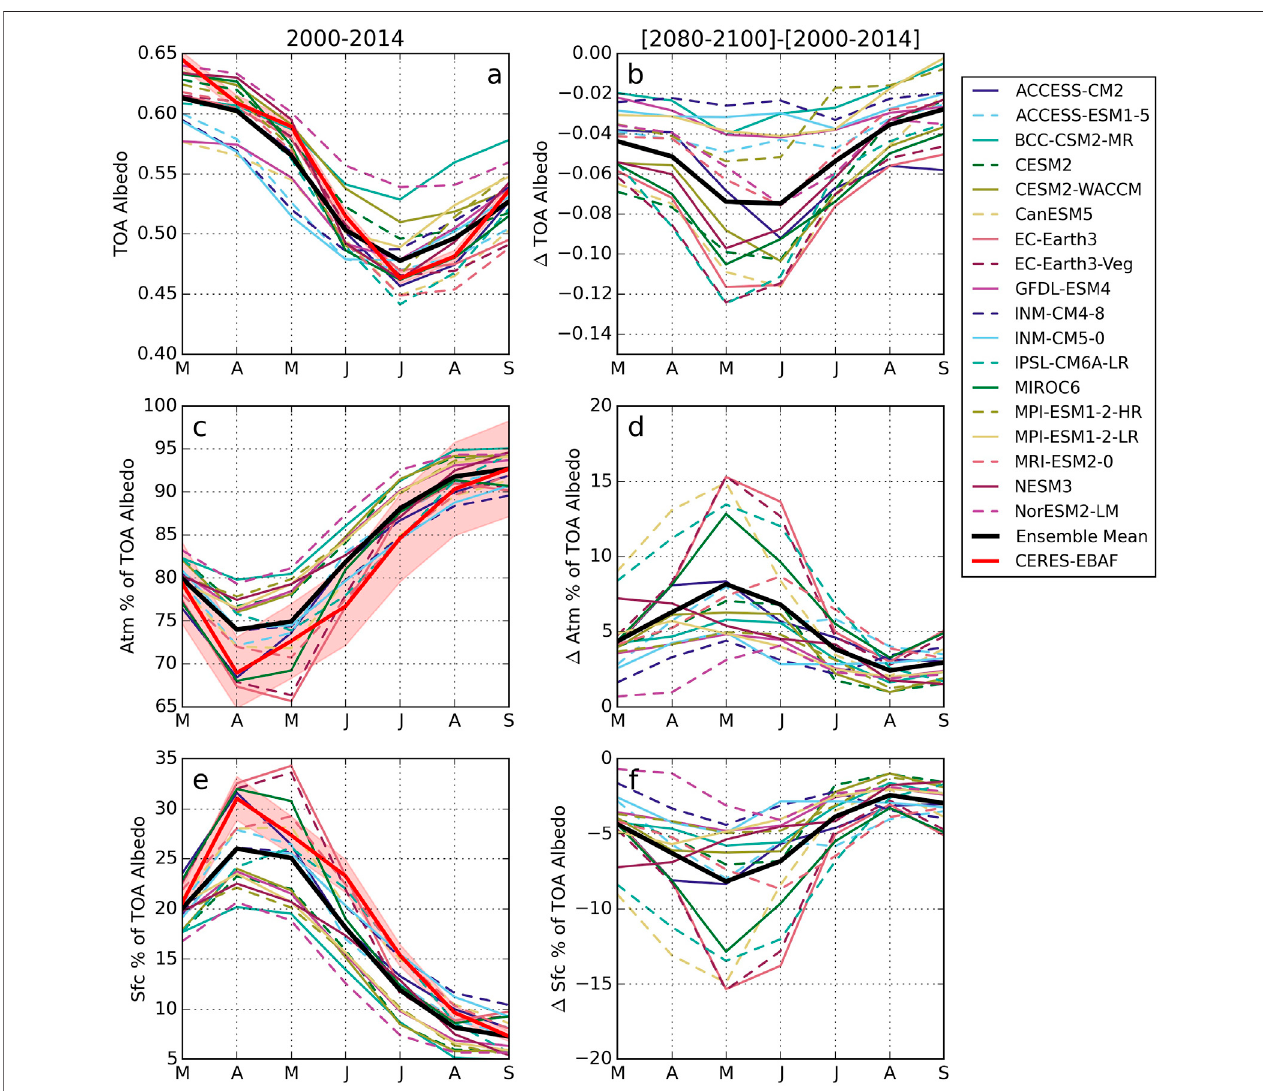
FIGURE 3 | Mean TOA albedo (A) and fraction of the TOA albedo contributed by the atmosphere (C) and surface (E) over 2000 – 2014 in CMIP6 and observations (CERES-EBAF),MarchthroughSeptember.Differencesbetweenhistoricalandendofcentury(2080 – 2100)fractionalTOAcontributionsareshownin (B , D , F) ,calculated with SSP585. Ensemble means are shown in black. Light red shading represents uncertainty in CERES-EBAF, found by calculating annual fractional errors for each component and multiplying by the monthly values.